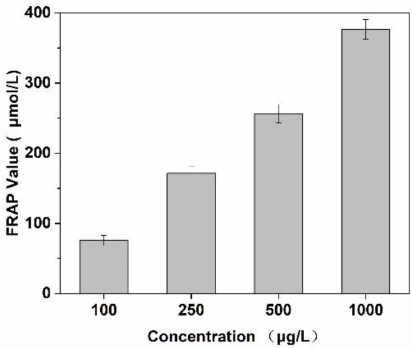
Figure 8. Ferric-reducing antioxidant power assay of Cornus officinalis peptides. All values are mean ± SD ( n = 3).